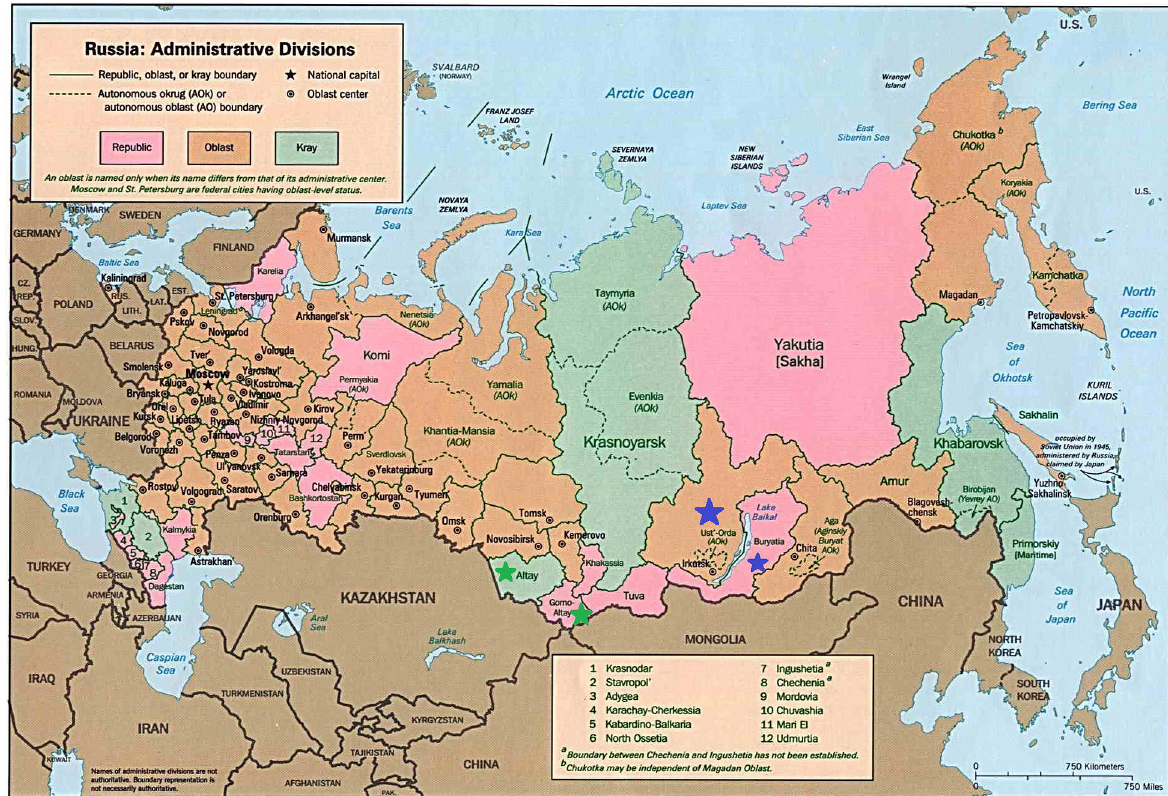
Fig. 1. Remote regions of Russia containing the Altai Mountains and lake